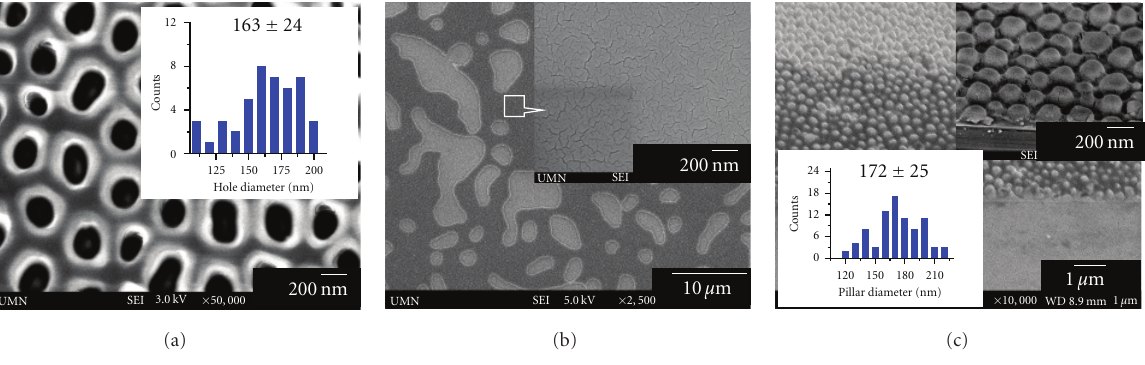
Figure 2: SEM plane-view images of (a) AAO mold; inset is the pore diameter distribution, (b) as-imprinted resist by using mold without SiO 2 coating; inset is the magnified view of the indicated area, and (c) as-imprinted resist pillars by using the mold with thin ∼ 2-3 nm SiO 2 coating. Insets in the upper right and left bottom corners are the magnified view and distribution of resist pillar diameter,